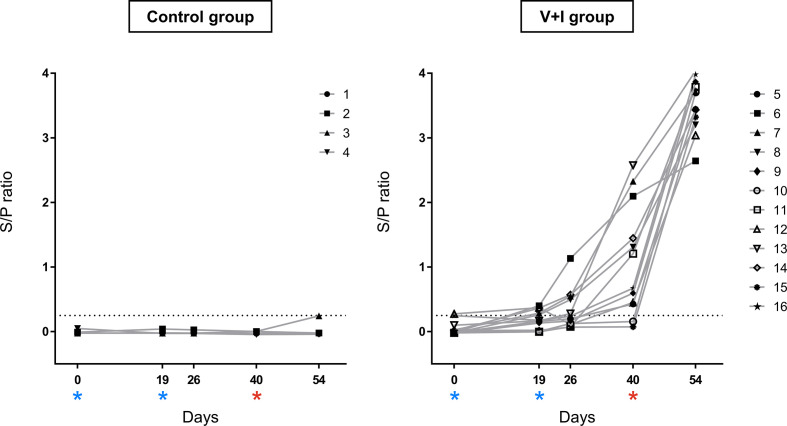

Salmonella-specific antibodies in serum over the course of the experiment. Salmonella-specific antibodies were measured by ELISA in serum of all animals. Sample to positive (S/P) ratios were calculated by dividing optical densities (OD) of samples by OD of the positive reference control. The dotted line represents the cut-off at a S/P ratio of 0.25. Results < 0.25 were defined as negative, samples ≥ 0.25 as positive. The left graph shows ratios for control animals, the right graph for vaccinated and infected animals. Dates of vaccinations (SD0, SD19) are indicated by blue asterisks, date of infection (SD40) by a red asterisk. The combination of different symbols and numbers represent values of individual animals.